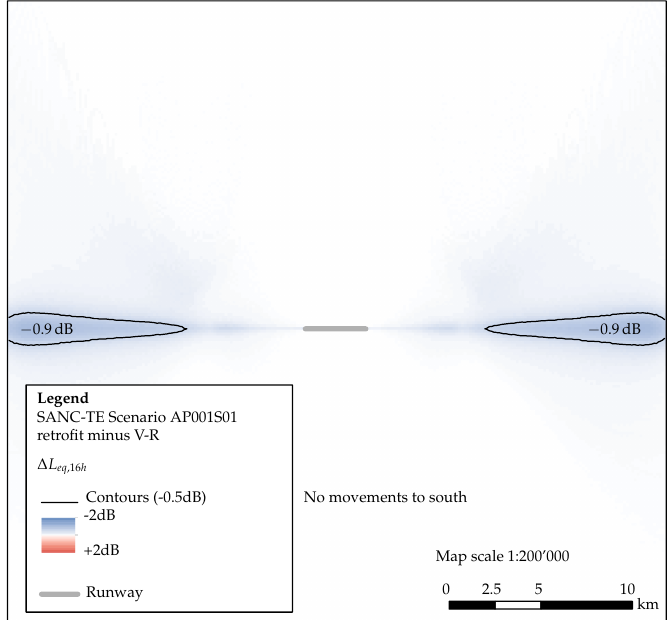
Figure 17. Level differences of L eq ,16 h between variant “retrofit” vs.